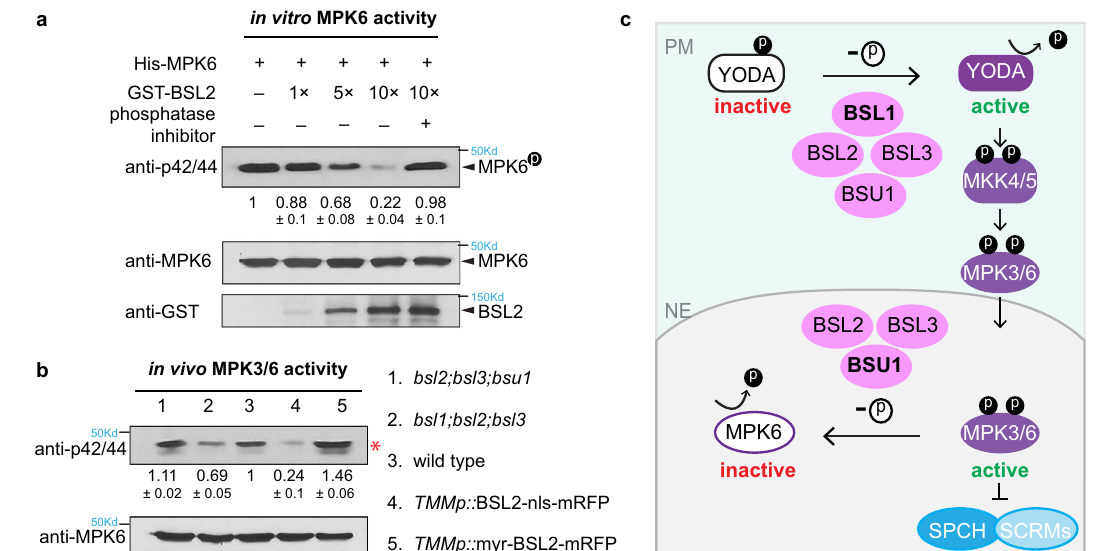
Fig. 6 Negative regulation of BSL phosphatases on MAPKs in vitro and in vivo. a Kinase activity of the recombinant MPK6 protein in the presence or absence of BSL2 was examined in vitro. MPK6 and BSL2 were fused histidine-tag (His) and glutathione S-transferase (GST), respectively. phosphorylated MPK6 was detected by immunoblot using anti-phospho-p42/p44 antibody. Protein levels of His-MPK6 or GST-BSL2 were examined using anti-MPK6 or anti-GST antibody, respectively. Numbers indicate relative amount of phosphorylated MPK6 protein of three biological replicates. Data are presented as mean ± SD. b Phosphorylated MPK3/6 (activity) levels in 5-dpg Arabidopsis seedlings were detected by anti-phospho-p42/p44 (top). Total proteins were extracted, and immunoblotting assays were performed using anti-phospho-p42/p44 (top) and anti-MPK6 (bottom). Numbers are mean ± SD, intensity quanti fi cation of phosphorylated MPK6 bands (red asterisk). n = three biological replicates. a , b Representative results of assays performed three times. c A working model: A BSL phosphatases-based signaling dichotomy, through spatial compartmentalization of the regulation on distinct components of the linear YODA MAPK pathway, controls stomatal development in Arabidopsis . At the cell cortex close to the PM, BSL1 is a predominant regulator, together with the other three BSL phosphatases, activating the MAPKKK YODA to promote MAPK signaling. Activated MPK3/6 molecules phosphorylate the key stomatal fate transcription factors, SPCH and ICE1/SCRMs, for degradation, thereby suppressing stomatal production. In the nucleus, BSU1 plays a primary role, together with BSL2 and BSL3, deactivating MPK3/6, resulting in stabilized SPCH and ICE1/SCRMs, thereby promoting stomatal